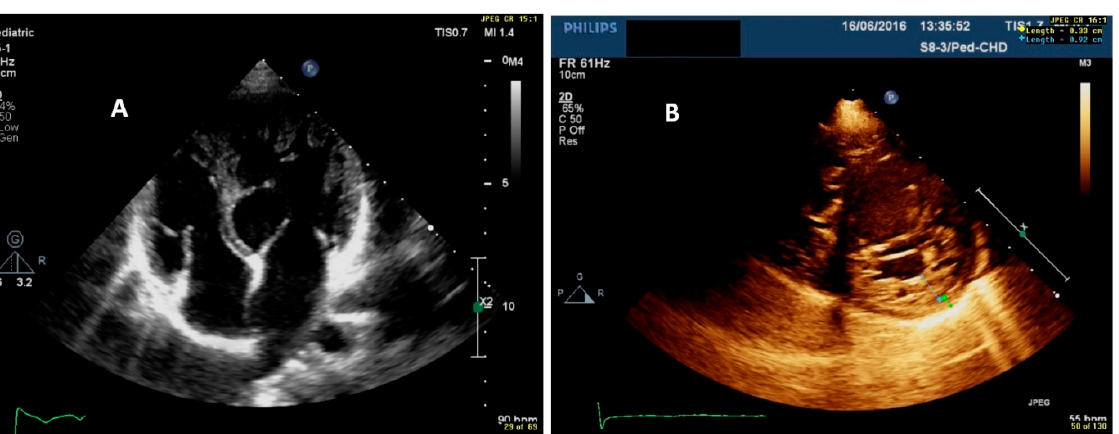
Figure 3. Cardiovascular magnetic resonance study in a patient with LVNC-short axis projection: noncompacted left ventricular layer. Cardiopulmonary exercise test (CPET) . CPET (ergospirometry) was performed in 10 (31%) patients. Peak oxygen absorption (peak VO2) ranged from 15.9 mL/kg/min to 43.5 mL/kg/min, and in two patients (6%), it was below 18 mL/kg/min. The respiratory exchange rate (RER) ranged from 0.84 to 1.29 and was above 1.05 in six patients (19%).